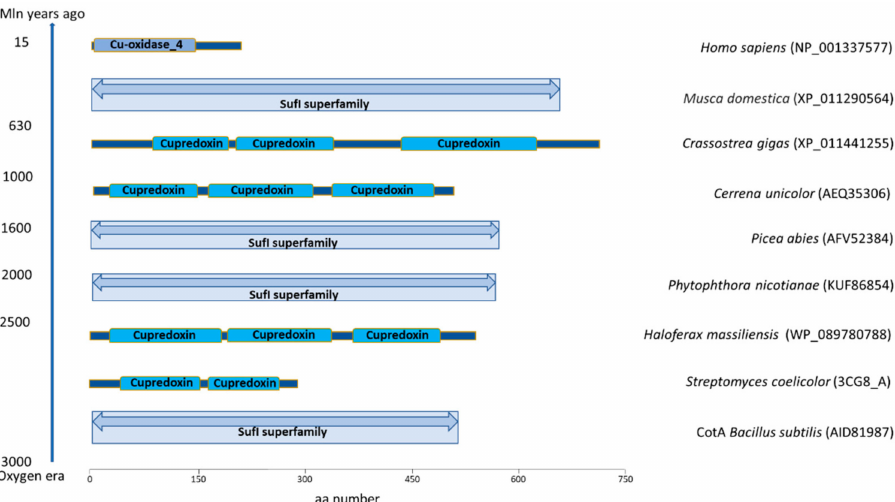
Figure 1. Schematic representation of the molecular evolution of laccases (based on Komori and Higuchi [11] and Nakamura and Go [16]). The oval shapes represent blue-copper-binding sites. The classes of protein domains are marked in pale and dark blue. Dots represent copper types.